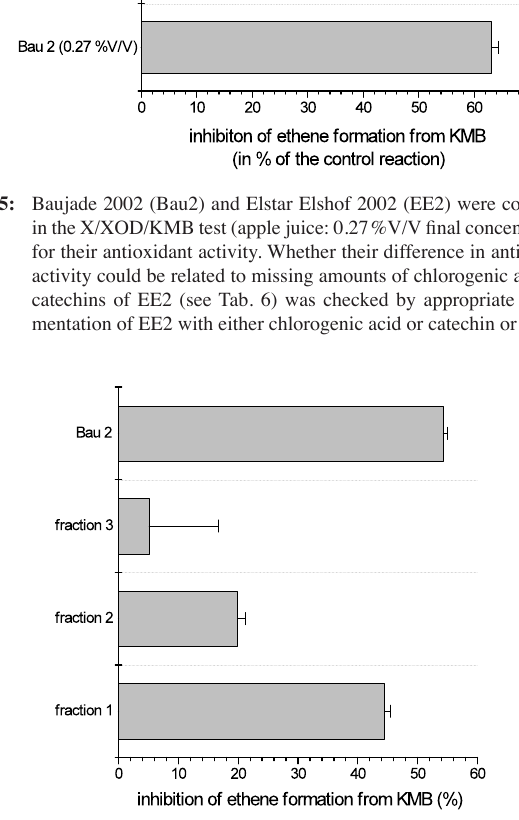
Fig. 6: Three fractions of the apple juice “Baujade 2002” (Bau2), received by Sephadex column chromatography, were analyzed in the X/XOD/ KMB test. The antioxidant activity is plotted as inhibition of ethene formation from KMB (in % of the control reaction (100%, produc - ing 8.7 ± 0.4 nmol ethene) and compared to Bau2 (0.27%V/V final concen tration). Fraction1mainly contained HCAs and catechins, frac - tion2 oligomeric catechins and flavanols whereas fraction3 consisted of poly meric flavanols. The fractions were also analyzed by HPLC and the Butanol/HCl method for proanthocyanidins (Tab. 7).